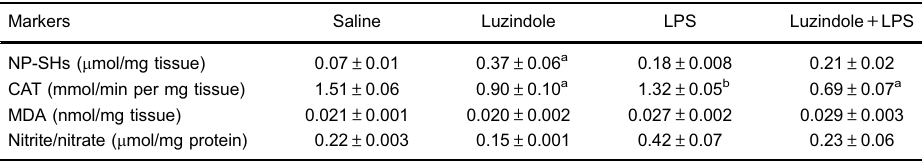
Table 4. Antioxidant activity of the experimental mice after treatment with saline, Luzindole, lipopolysaccharide (LPS), and Luzindole + LPS. Markers Saline Luzindole LPS Luzindole + LPS NP-SHs ( m mol/mg tissue) 0.07 ± 0.01 0.37 ± 0.06 a 0.18 ± 0.008 0.21 ± 0.02 CAT (mmol/min per mg tissue) 1.51 ± 0.06 0.90 ± 0.10 a MDA (nmol/mg tissue) 0.021 ± 0.001 Nitrite/nitrate ( m mol/mg protein) 0.22 ± 0.003 0.23 ± 0.06 Data are reported as means ± SE. NP-SHs: non-protein sulfhydryls; CAT: catalase; MDA: malondialde- hyde. a P o 0.05 compared with saline. b P o 0.05 compared with Luzindole + LPS (ANOVA followed by Bonferroni ’ s